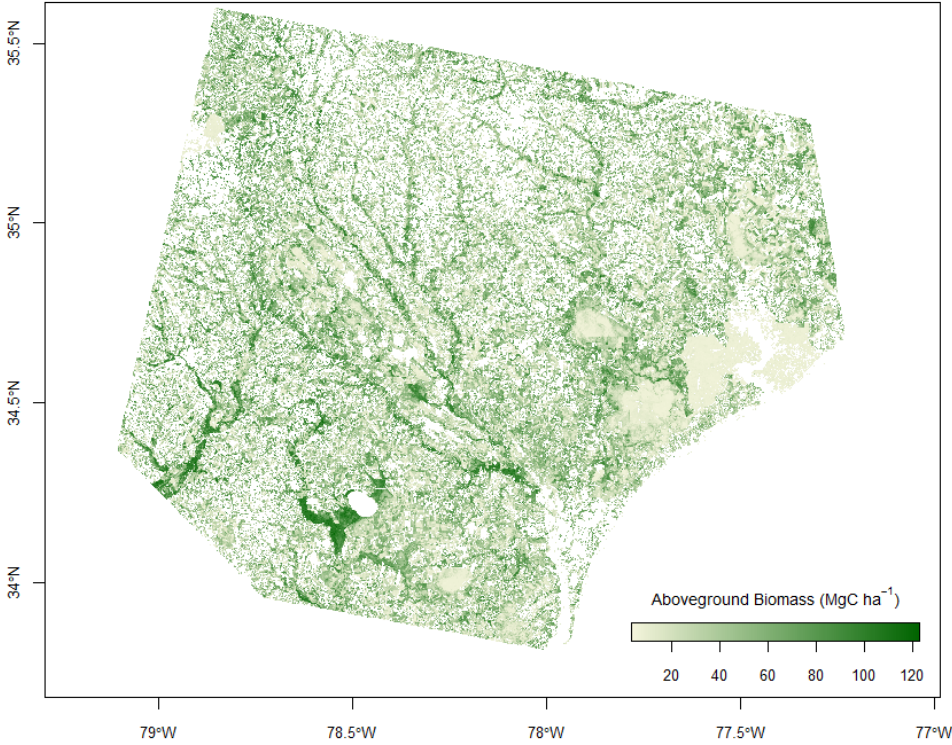
Figure 5. Spatial distribution of biomass estimated with the best model for the study area in eastern North Carolina. Nonforest areas are masked out based on the 2016 National Land Cover Data.